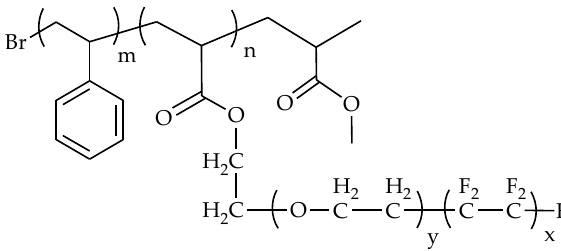
Figure 12. Chemical structure of poly(ethoxylated fluoroalkyl acrylate)- b -polystyrene comb-like block copolymer with amphiphilic side chains [95].